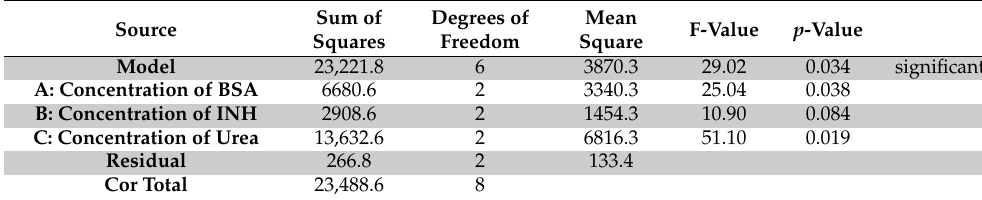
Table 3. ANOVA table for the average particle